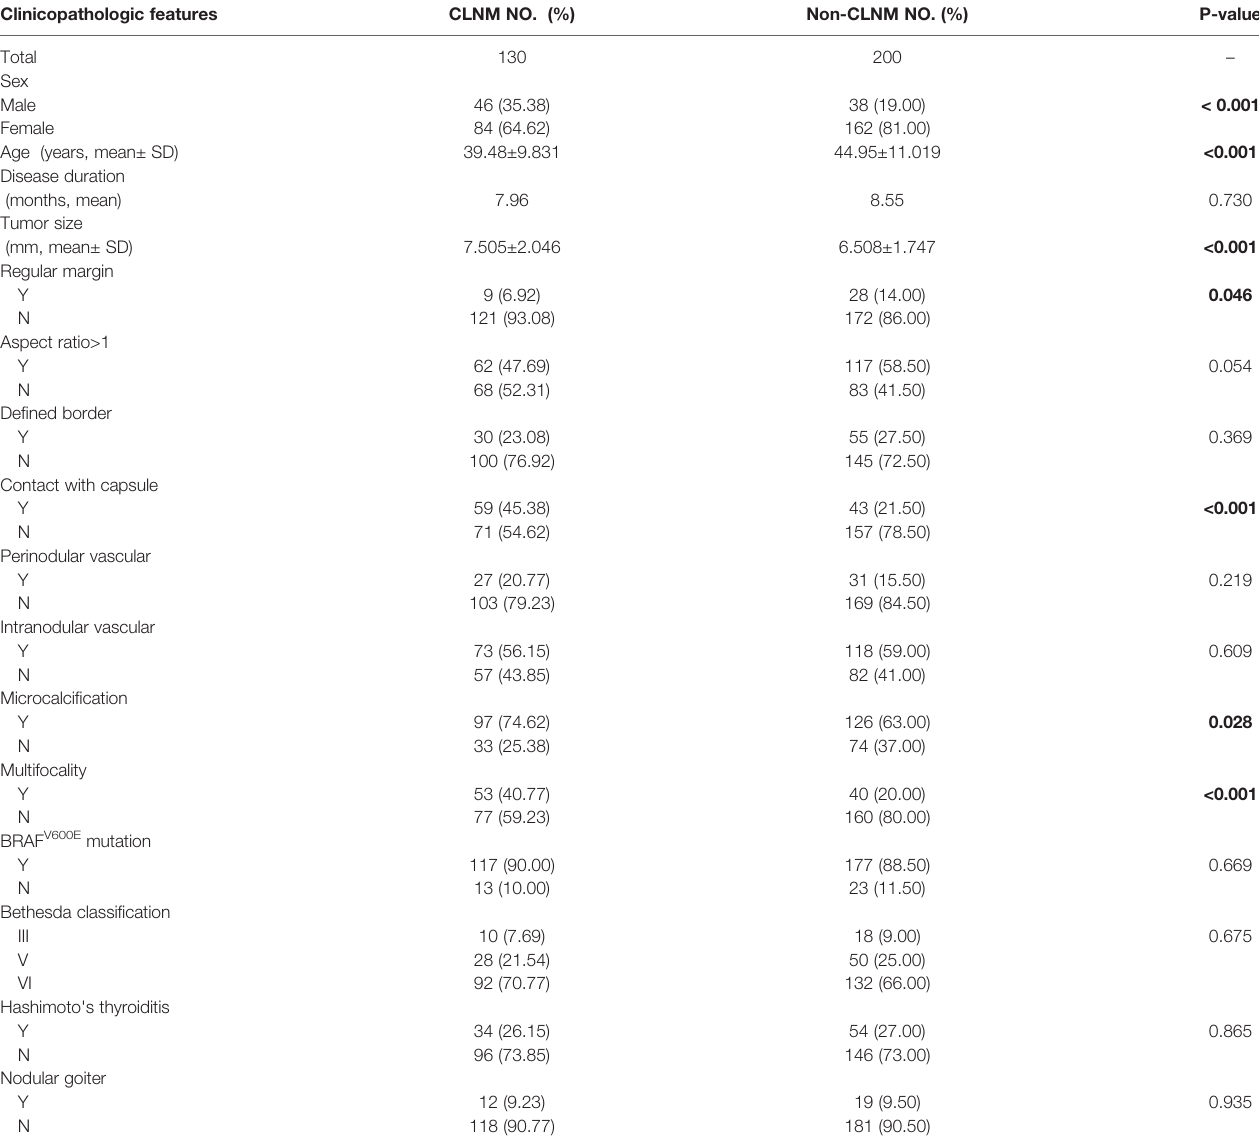
TABLE 2 | Basic clinicopathologic characteristics and US-FNA features PTC (cT1aN0). Clinicopathologic features CLNM NO.